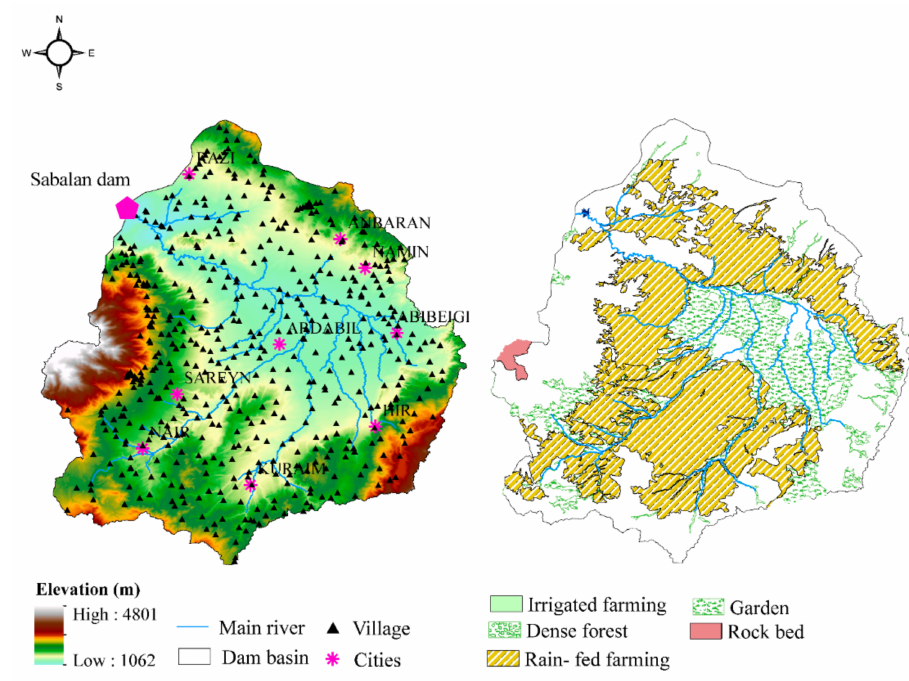
Figure 1. Basin of the Sabalan dam reservoir and digital elevation map of the basin.